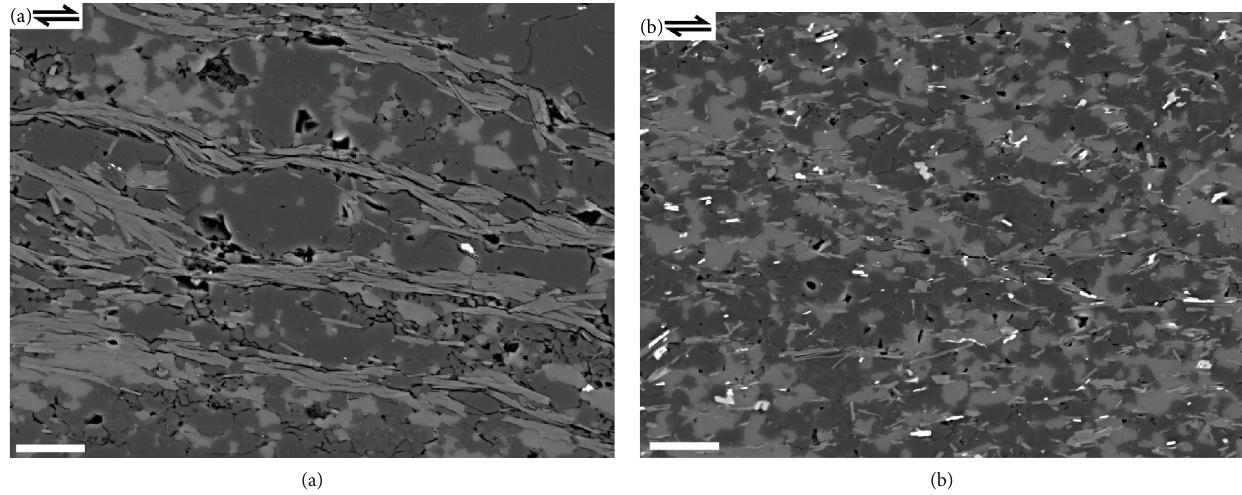
Figure 7: Scanning electron microscope backscatter electron images of (a) layers of interconnected phyllosilicate networks in a mylonite and (b) a representative ultramylonite depicting a fi ne-grained mixture, with a random distribution of all constituent phases of the rock. Quartz and albite are dark gray, K-feldspar is light gray, and phyllosilicates are light gray and lamellar shaped. White bars = 20 μ m